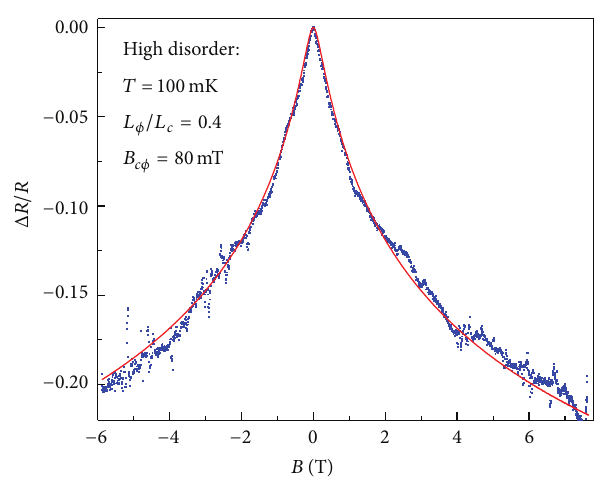
Figure 5: The measured magnetoresistance of a large scale graphene sample on glass (blue dots). The relative resistance and the fit (red line) using (19) with fitting parameters 𝐵 𝑐𝜙 = 3.5 mT, 𝐿 𝜙 /𝐿 𝑐 = = 55.1 T, and 𝐵 = 9 T are 0.0925 , 𝐵 0 𝑒 0